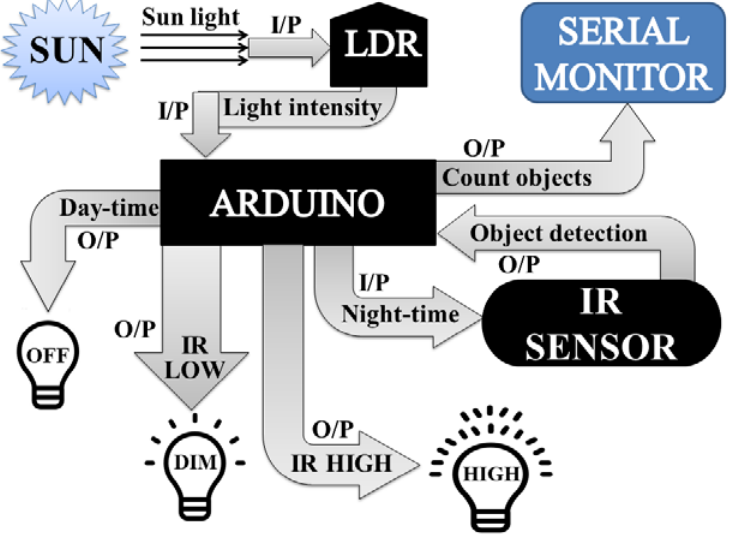
Figure 1. The architecture design of the automatic street light control system.